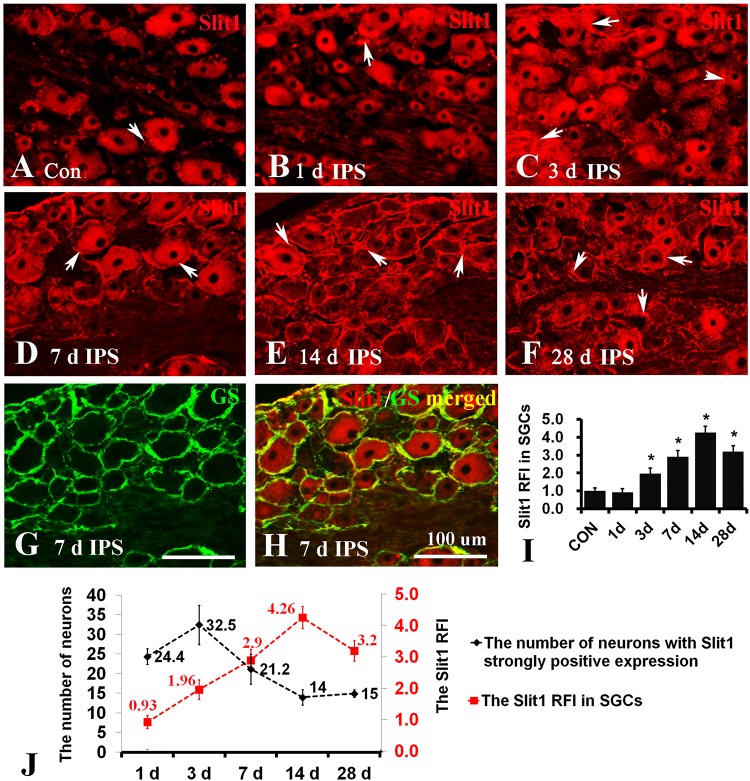
Slit1 expression in SGCs of injured DRG. Slit1 expression in the SGCs of injured DRG was detected by immunofluorescence histochemistry. (A) Slit1 (red) immunofluorescence staining of contralateral DRG sections randomly selected from the different groups. (B–F) Slit1 immunofluorescence staining of ipsilateral DRG at different time points after operation. The arrow indicates Slit1-positive SGCs. (G) GS (green) immunofluorescence staining of DRG sections on the 7th day after sciatic nerve crush. (H) Merged images from panels (D,E). (I) Summary histograms depicting the changes in the Slit1 RFI in SGCs (one-way repeated measures ANOVA, ∗
P < 0.01); RFI, relative fluorescence intensity. (J) Changes in the number of strongly Slit1-positive DRG neurons and the RFI of Slit1 expression in SGCs at different time points after injury are shown. Scale bar = 100 μm.